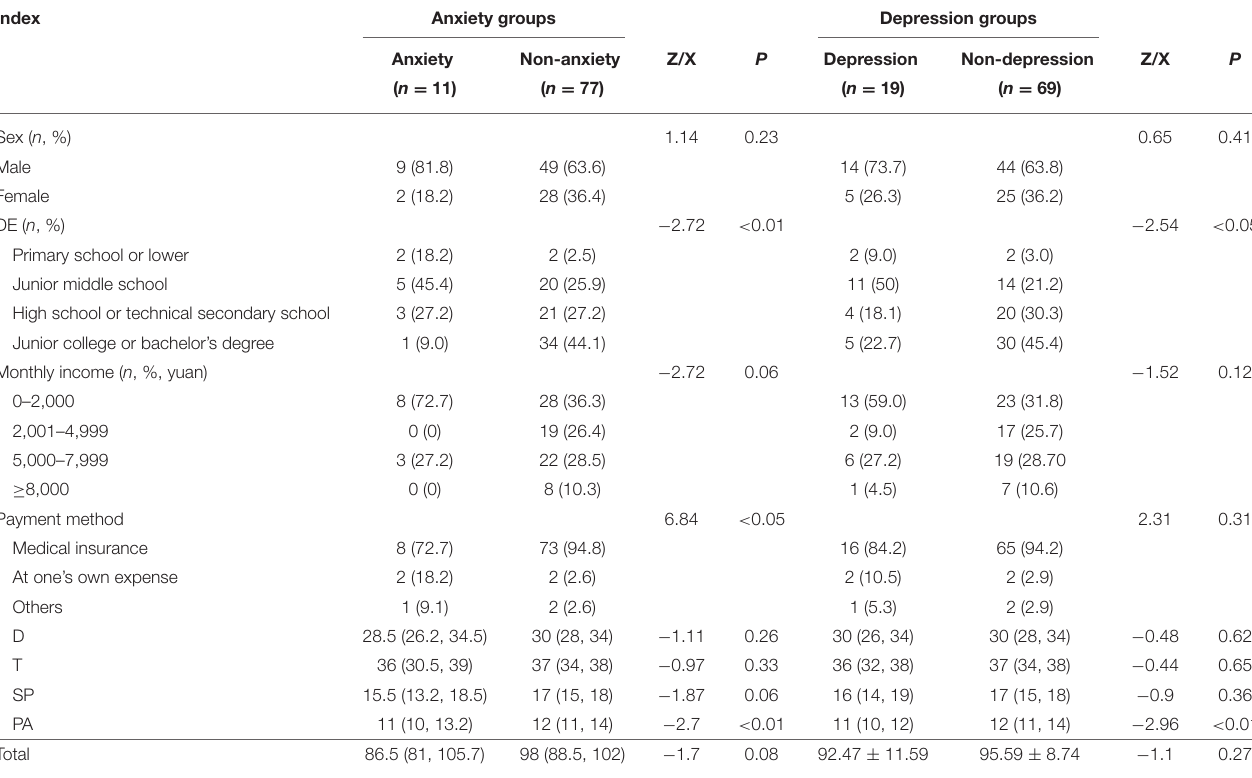
TABLE 5 | Comparison of creatine clearance, self-management ability, and general data between the anxiety and depression groups. Index Anxiety groups Depression groups Anxiety Non-anxiety